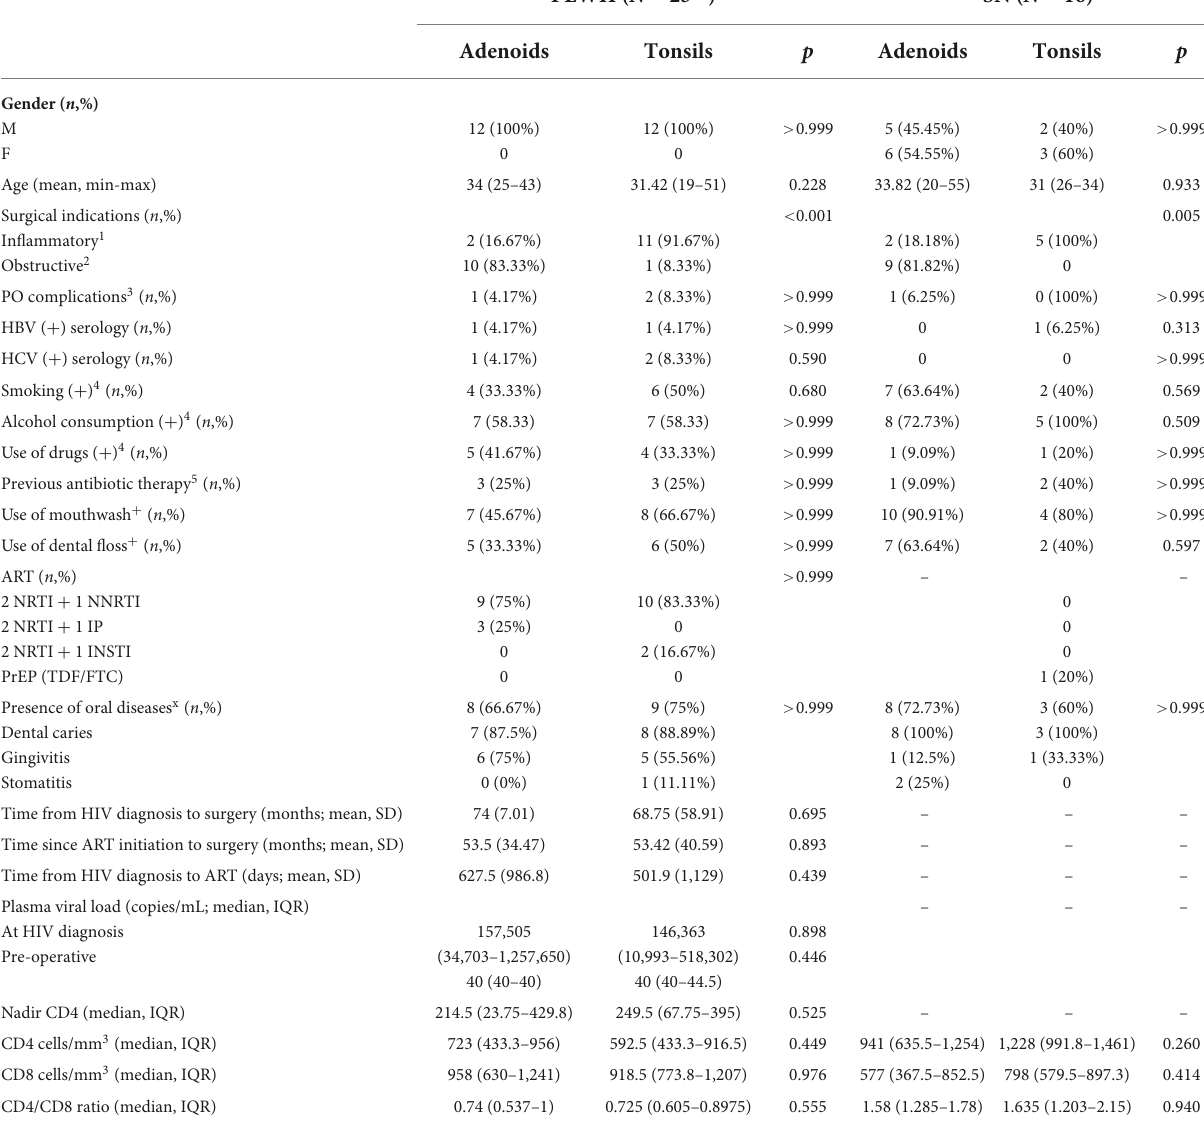
TABLE 1 Demographic and clinical characteristics stratified by HIV status and anatomical